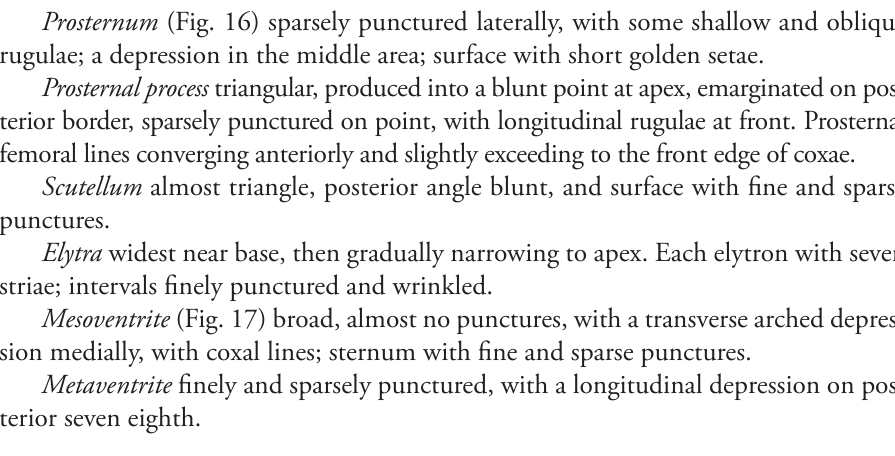
Figure 11. Habitus of Micrencaustes ( Mimencaustes ) serratimaculata sp. n. Scale bar 1.0 mm.